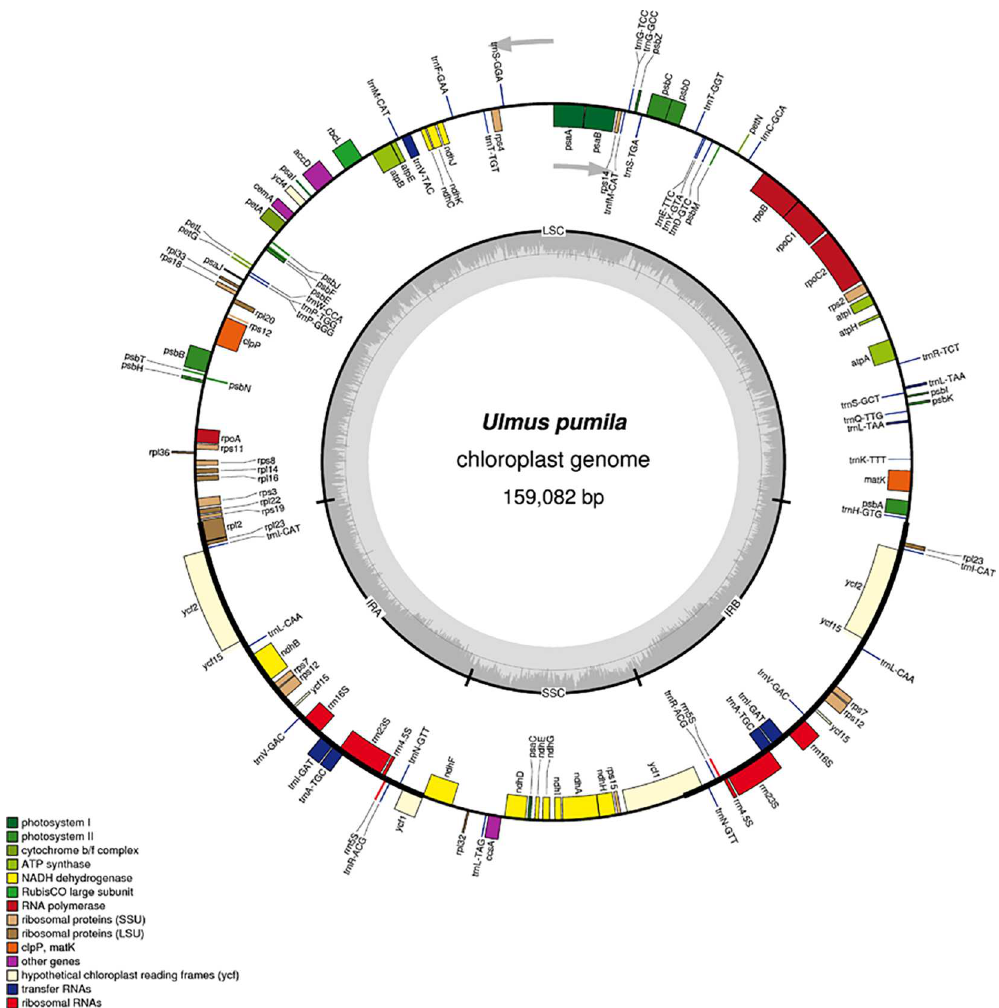
Fig 1. Gene map of the U . pumila chloroplast genome. Genes drawn inside the circle are transcribedclockwise, whilegenes outsideare transcribed counterclockwise. Gene functionalgroupsare